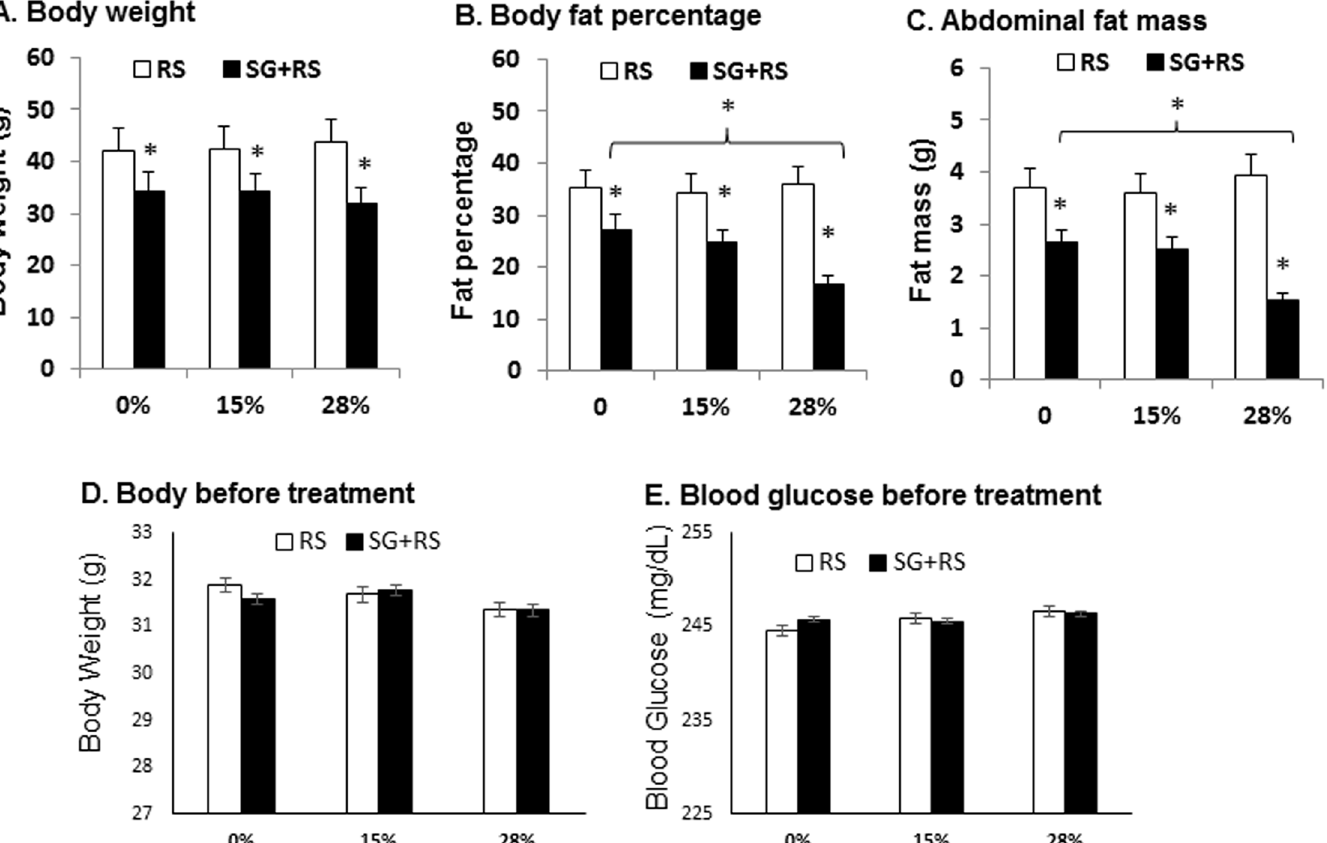
Fig 1. Body weight and adiposity. (A) Body weight of animals in response to treatment by SG and RS. (B) Body fat content as percentage of total weight. (C) Abdominal fat mass. (D) Body weight before treatment. (E) Blood glucose before treatment by SG and RG. The results are expressed as mean ± SEM (n = 9 – 10). * p < 0.05 versus RS